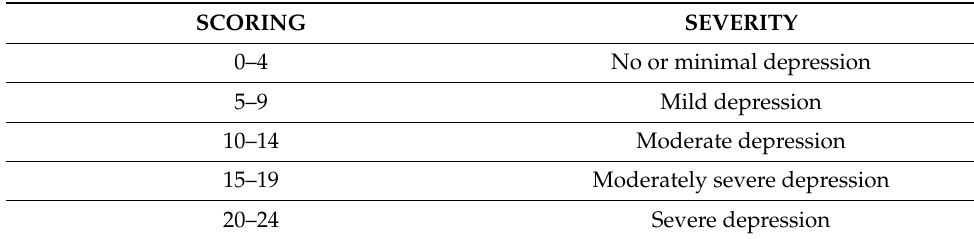
Table 2. PHQ-8 scoring